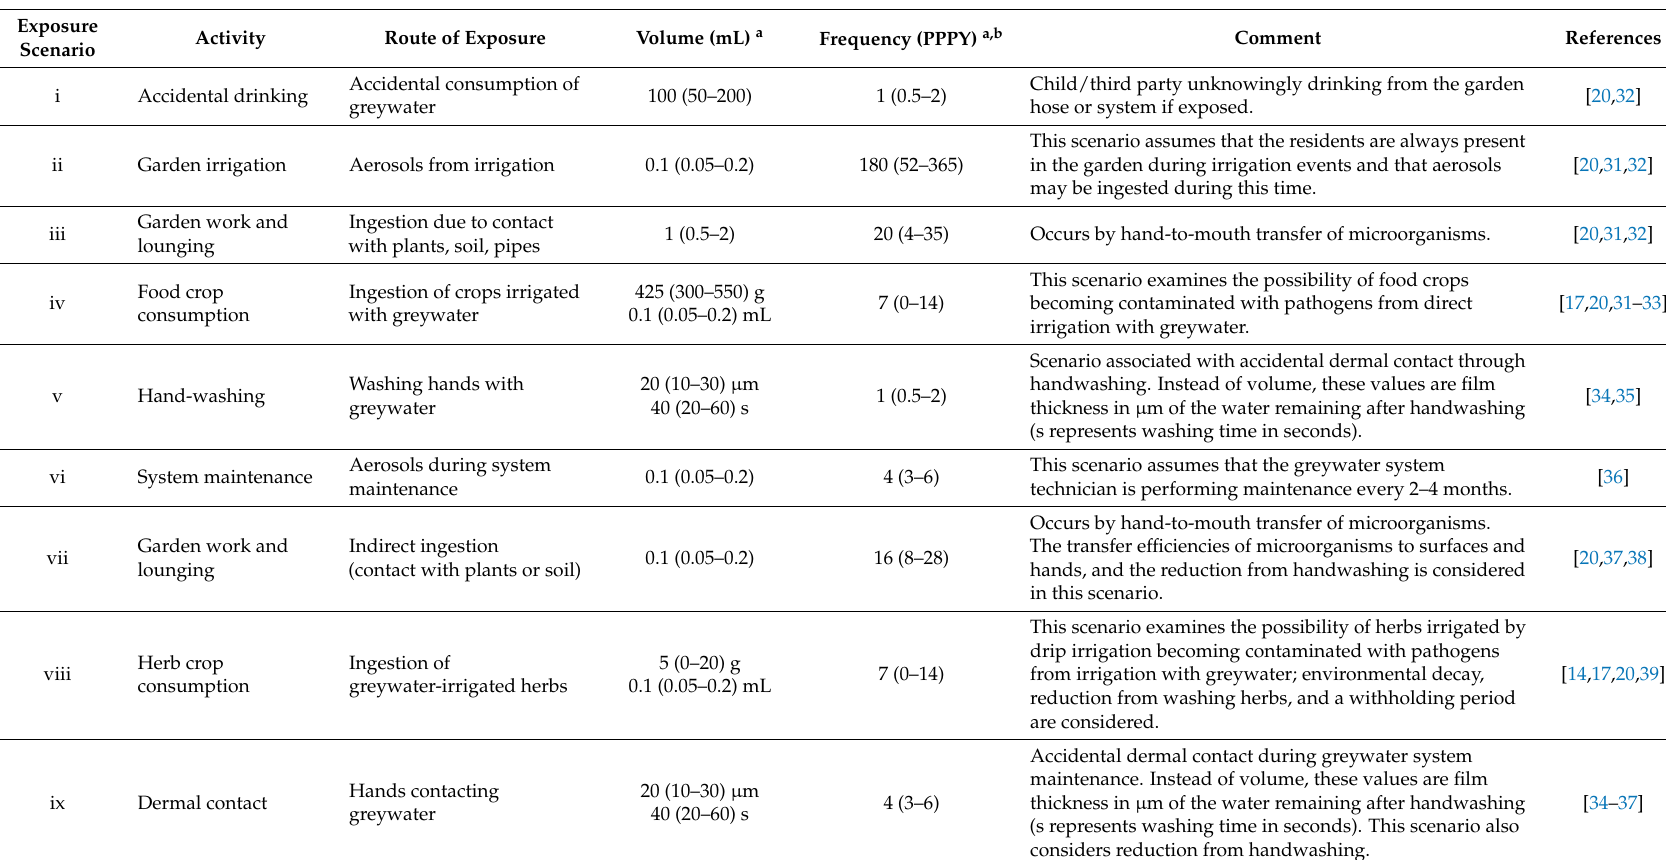
Table 2. Potential worst-case and best-practice scenarios of exposure to greywater under investigation in this study. Additional relevant parameters associated with the best-practice exposure scenarios are found in Appendix A, Table